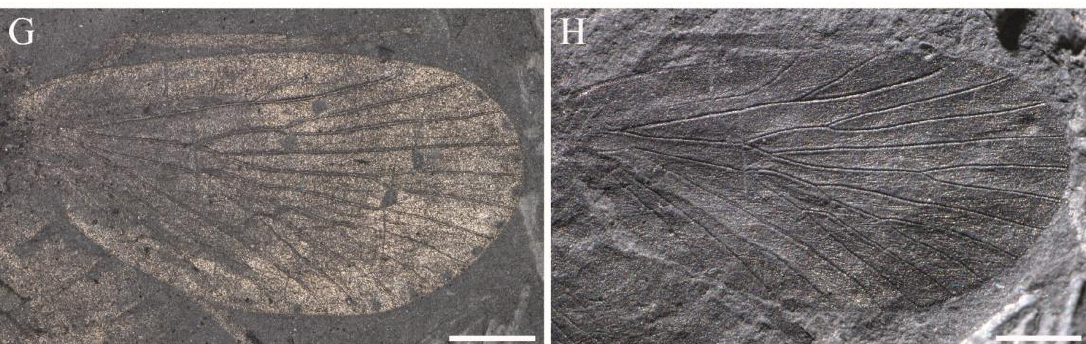
Figure 6. Sinoagetopanorpa lini sp. nov., NIGP200916 (holotype). ( A , B ) Photographs of part, showing general habitus; ( C , D ) Photographs of counterpart, showing general habitus; ( E , F ) Photographs of right forewing, enlargement from ( A , B ); ( G , H ) Photographs of left hind wing, enlargement from ( C , D ); ( A , C , E , G ) were taken when specimens were immersed under 70% alcohol in vertical reflected light; ( B , D , F , H ) were taken in oblique reflected light. Scale bars represent 1 mm in ( A – H ).